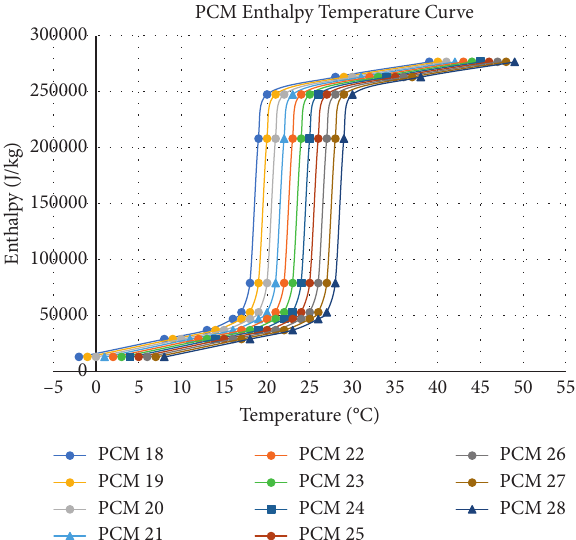
Figure 2: Enthalpy temperature curves for PCMs